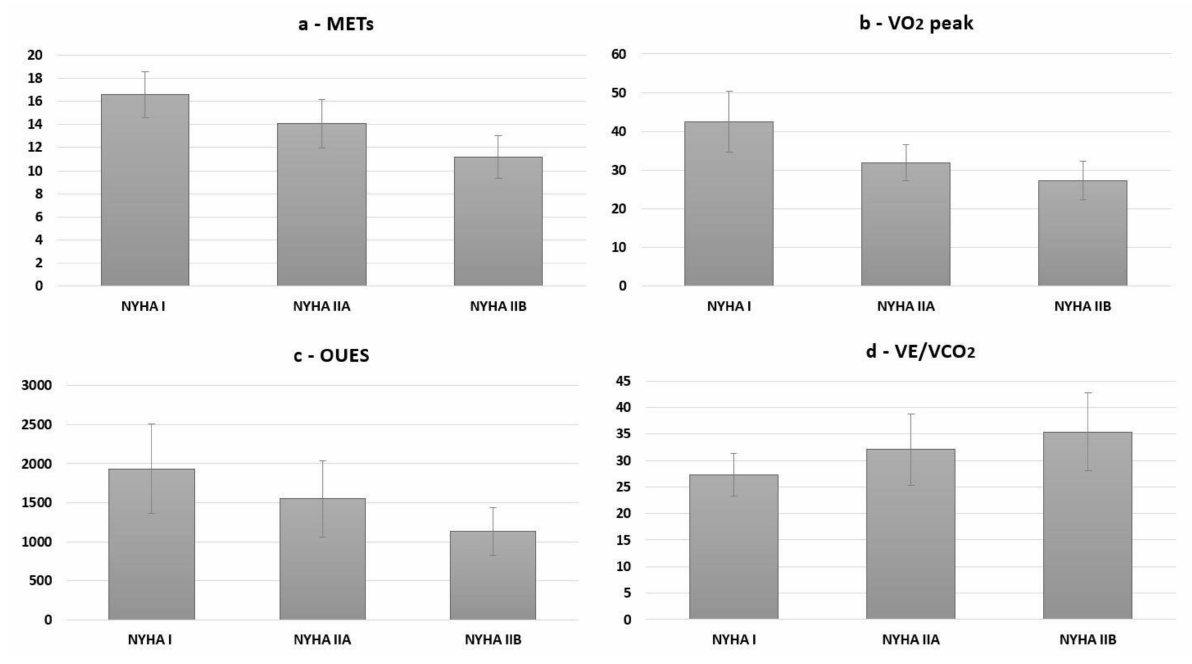
Figure 1. Functional and aerobic capacity as well as cardiorespiratory efficiency according to adapted NYHA-CHD classes. ( a ) shows maximal metabolic equivalents of task (METs), ( b ) shows peak oxygen consumption (VO 2 peak; mL · kg-1 · min-1), ( c ) shows the Oxygen Uptake Efficiency Slope (OUES; mL · log-l), and ( d ) shows the VE/VCO 2 at the anaerobic threshold. These CPET markers show a progressive degree of functional limitation and worsening of cardiorespiratory efficiency as the NYHA-CHD class increases. Data are presented as mean with standard